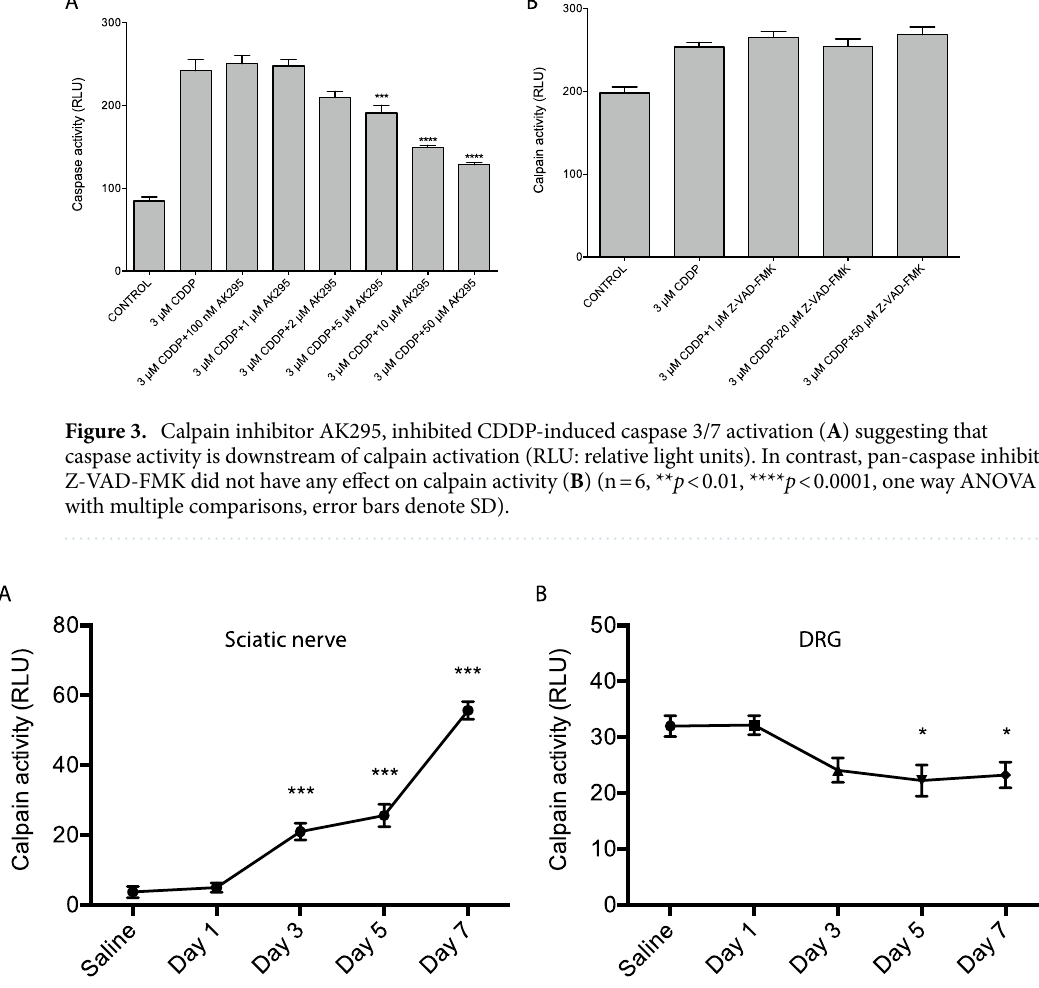
Figure 4. In-vivo time course of calpain activation in mice treated with CDDP. Calpain activation starts 3 days after CDDP in sciatic nerves and continues until 7 days post-injection ( A ). In contrast, there was no significant activation of calpain in DRG samples ( B ) (n = 5 per group, * p < 0.05, *** p < 0.005, one way ANOVA with multiple comparisons, error bars denote